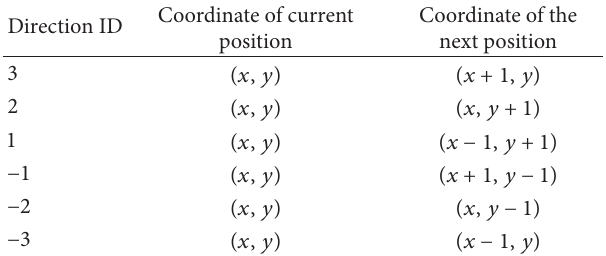
Table 8: The calculations in different